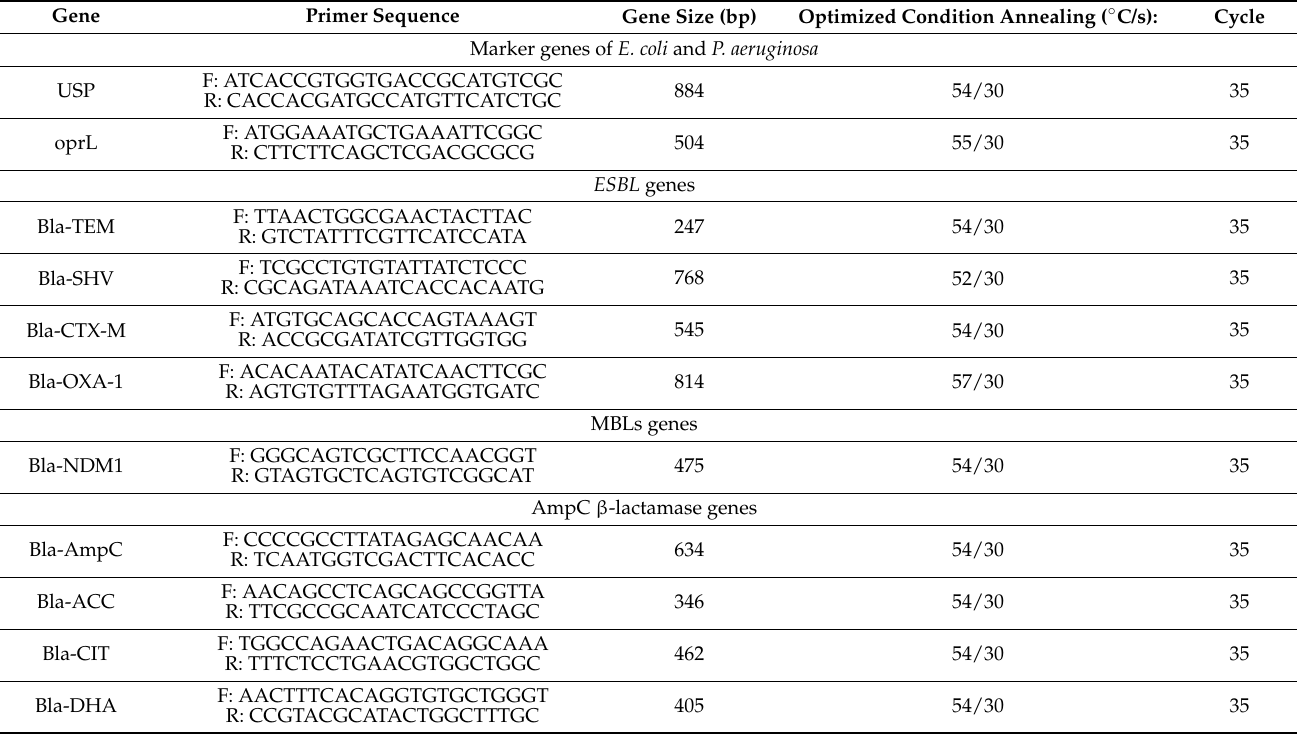
Table 9. Sequences of primers along with optimized conditions used in the current